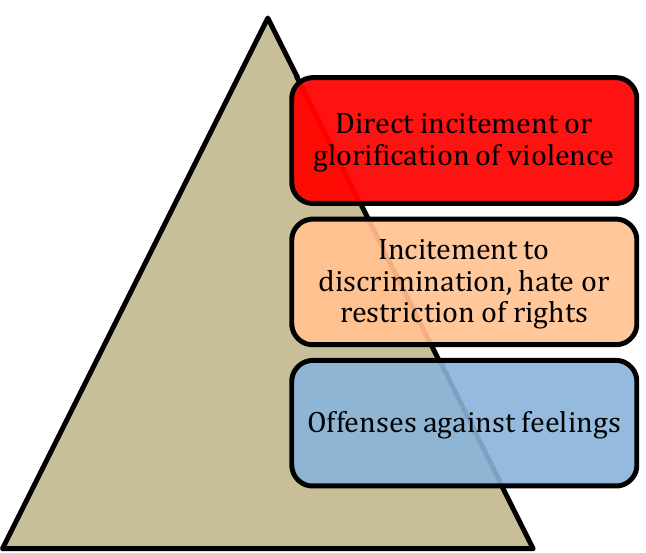
Figure 1. Theoretical types of hate speech from Miró (2016).